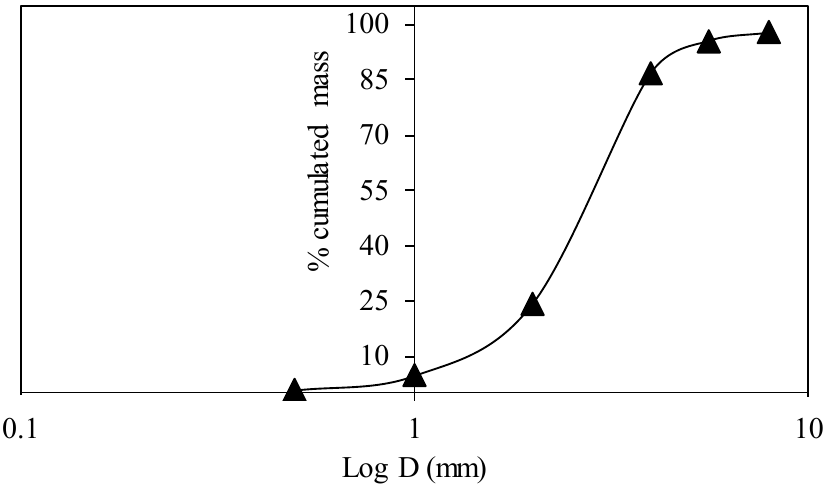
Figure 1. Grain size distribution curve of BP.